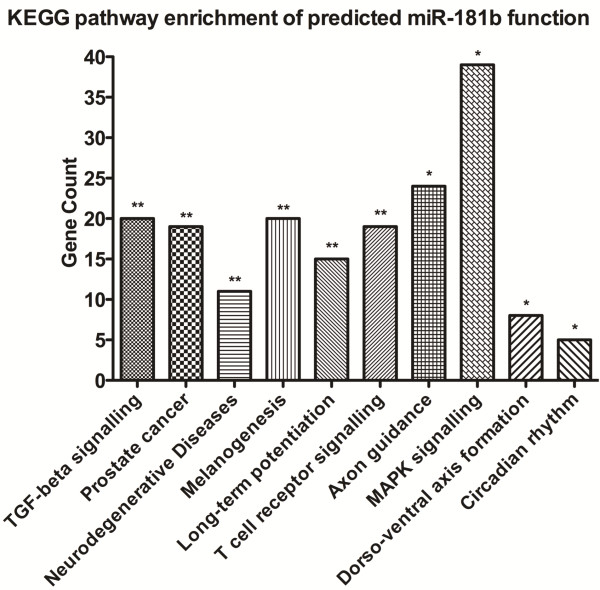
KEGG pathways analysis of predicted miR-181b target genes. KEGG pathways analysis of predicted target genes for
miR-181b revealed ten significantly enriched pathways: TGF-beta signalling (p=0.0023); prostate cancer (p=0.0037); neurodegenerative diseases (p=0.0061); melanogenesis (p=0.0062); long-term potentiation (p=0.0070); T-cell receptor signalling (p=0.0087); axon guidance (p=0.0106); MAPK signalling (p=0.0217); dorso-ventral axis formation (p=0.0236); and circadian rhythms (p=0.0410). MAPK: mitogen-activated protein kinase. Predicted target genes for
miR-181b were generated from the miRGen database and submitted for pathways analysis to DAVID.